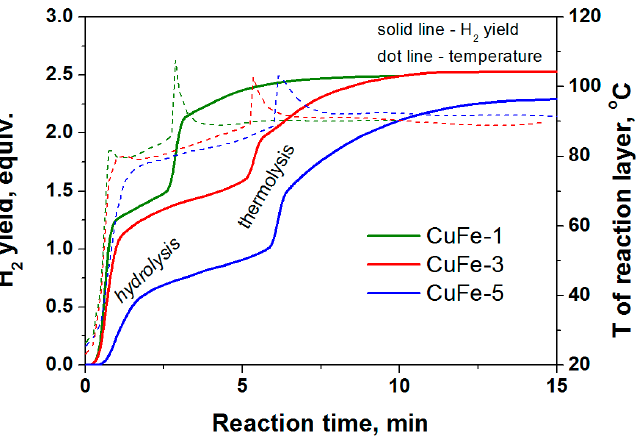
Figure 7. The activity of CuFe-combustion products (Table 2) in the catalytic hydrothermolysis of NH 3 BH 3 at external heating of reactor at 90 ° С and molar ratio of H 2 O/NH 3 BH 3 = 2. The solid lines are the hydrogen generation curves; the dotted lines are curves of temperature of reaction medium.